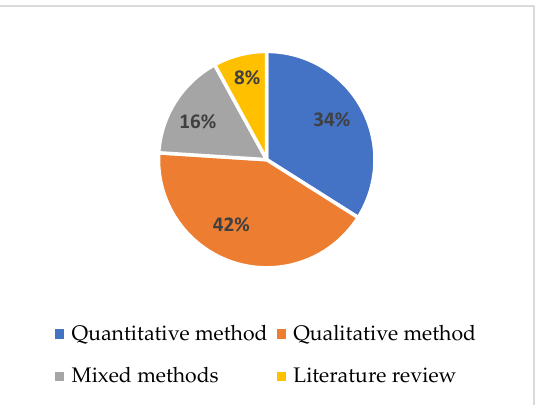
Figure 3. Overview of research approaches. Source: Authors’ own (2023). Table 3. Summary of research methods used. Source: Authors’ own (2023).